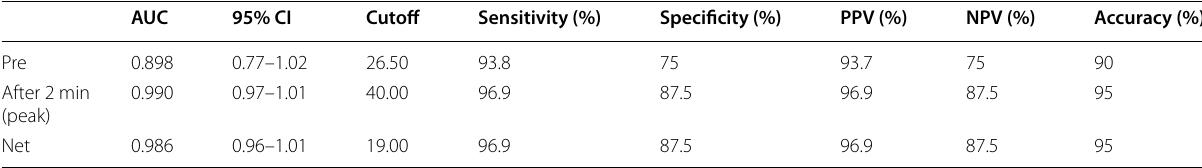
AUC: area under the curve, CI: confidence interval, PPV: positive predictive value, NPV: Negative predictive